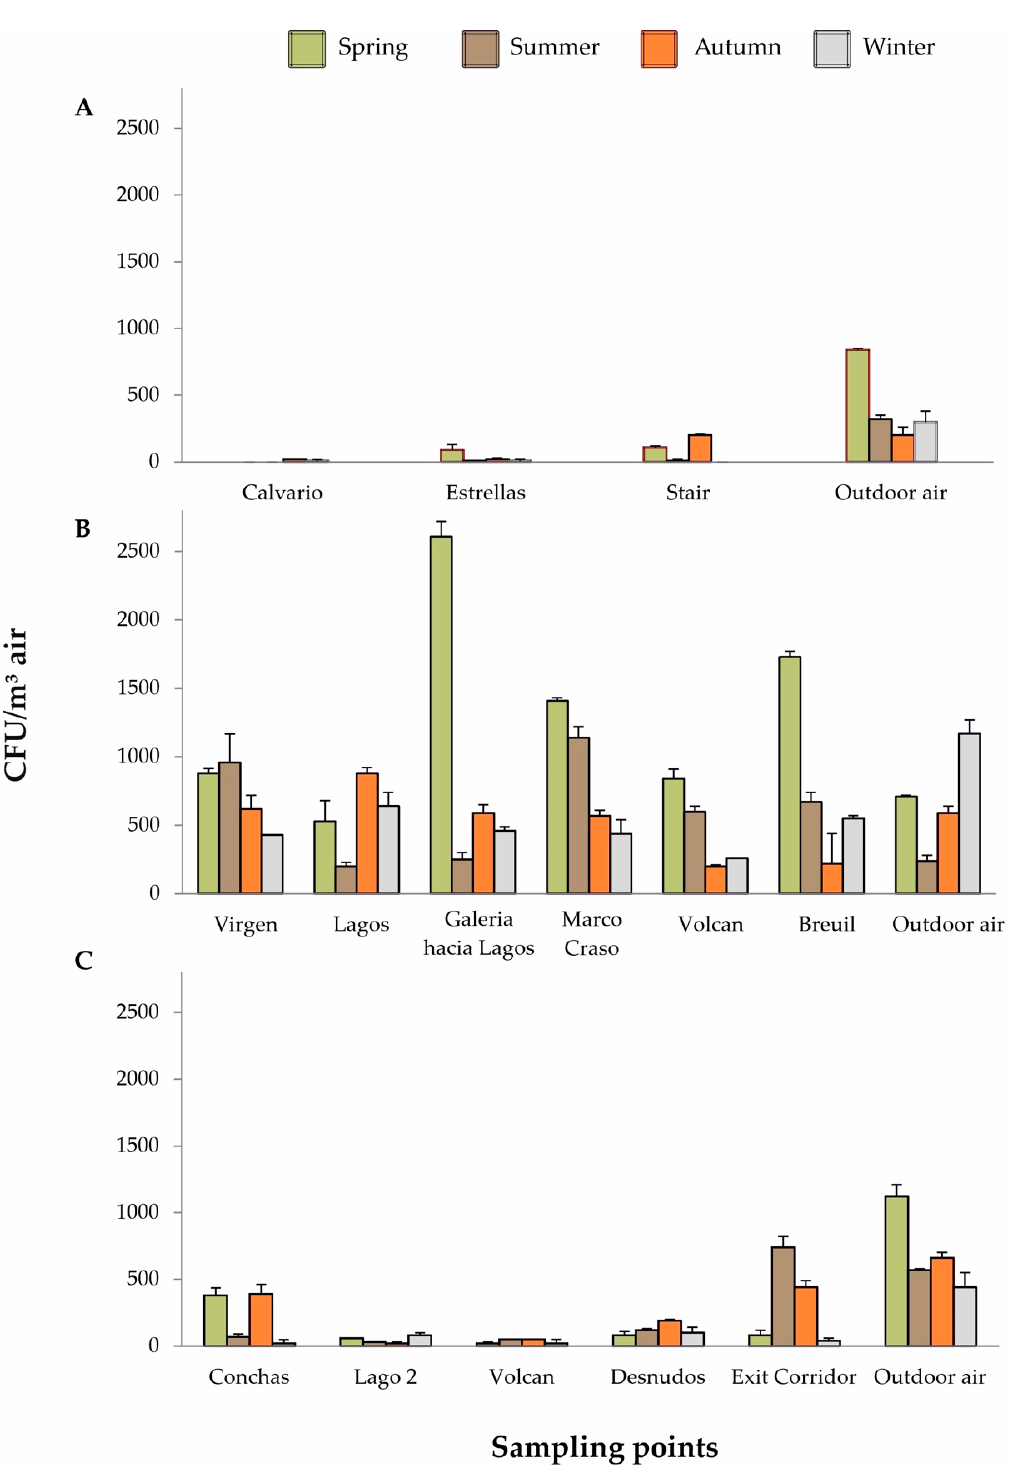
Figure 5. CFU/m 3 of fungi in the four samplings. ( A ) Cueva de Ardales; ( B ) Cueva del Tesoro; ( C ) Gruta de las Maravillas. The DNA was purified by phenol/chloroform extraction and ethanol precipitation